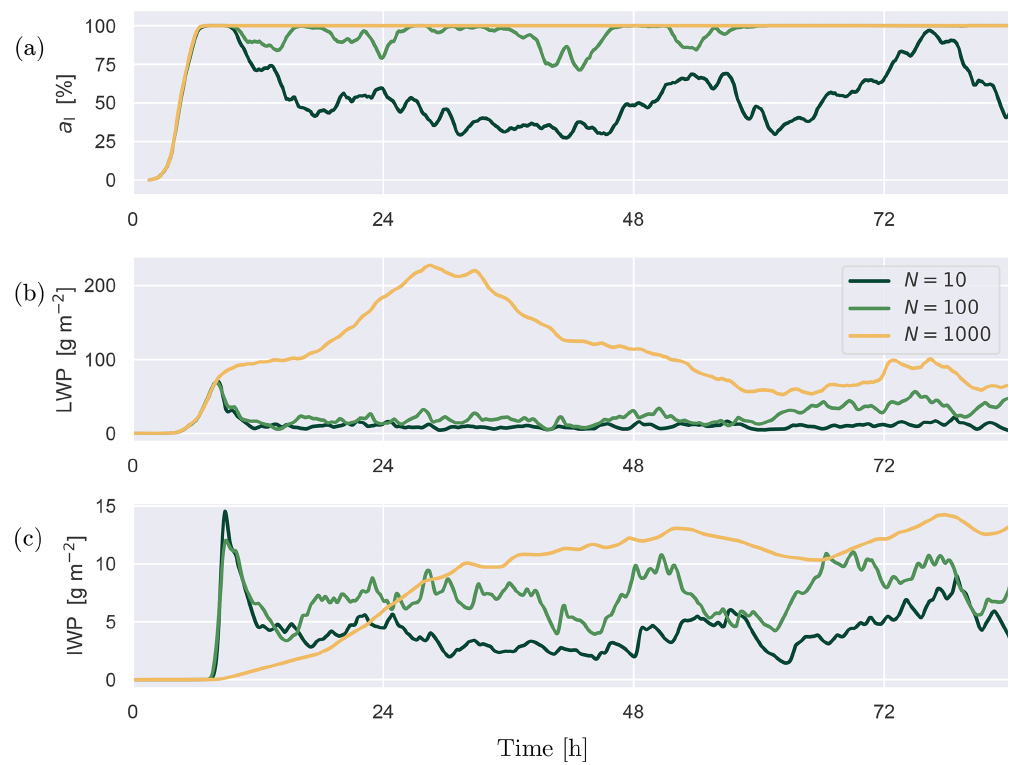
Figure 13. Time series of domain-averaged microphysics properties during the three CCN sensitivity experiments. (a) Liquid cloud cover a l . (b) Cloud liquid water path LWP. (c) Cloud ice water path